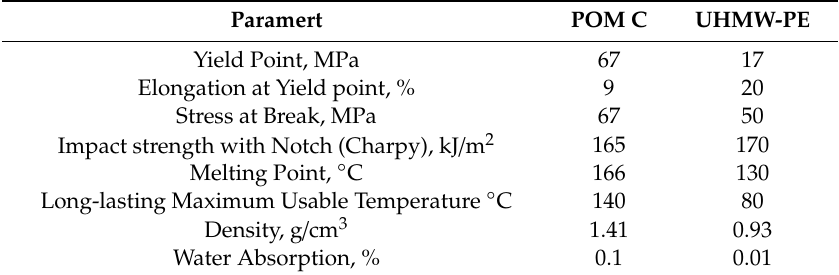
Table 1. The parameters of the POM C [49] and UHMW-PE [50] polymers used for